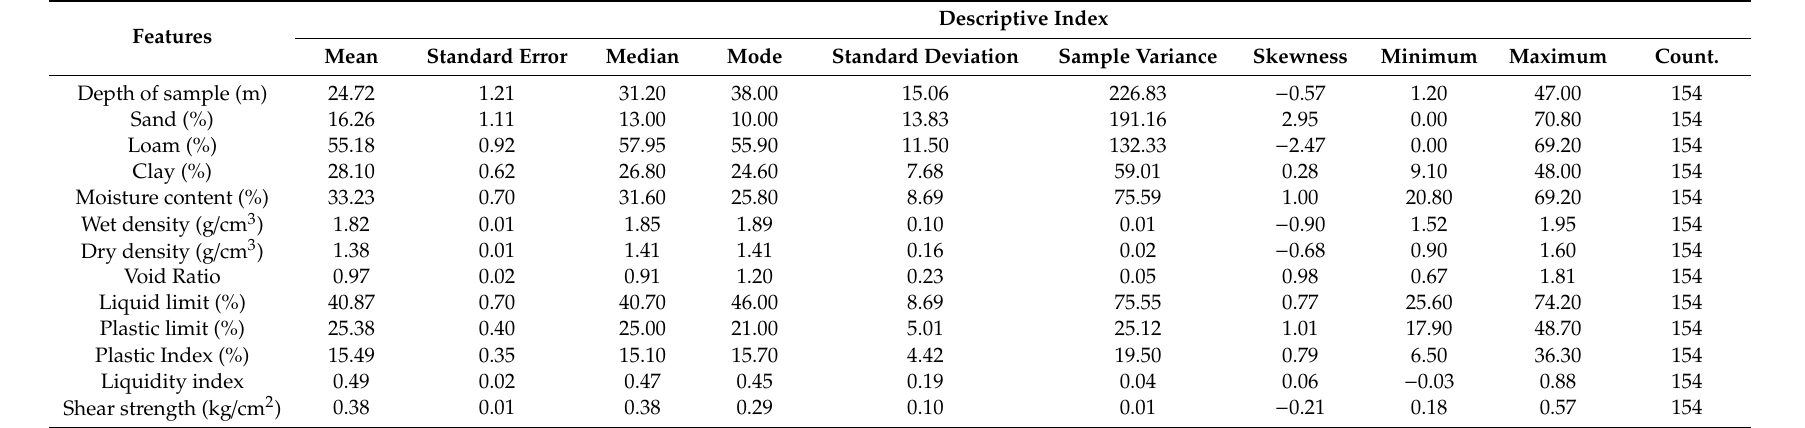
Table 1. Descriptive statistics of the used